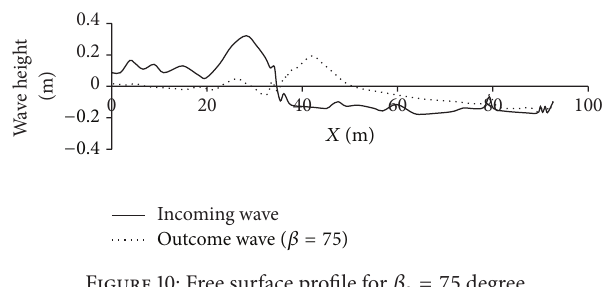
Figure 10: Free surface profile for 𝛽 2 = 75 degree.